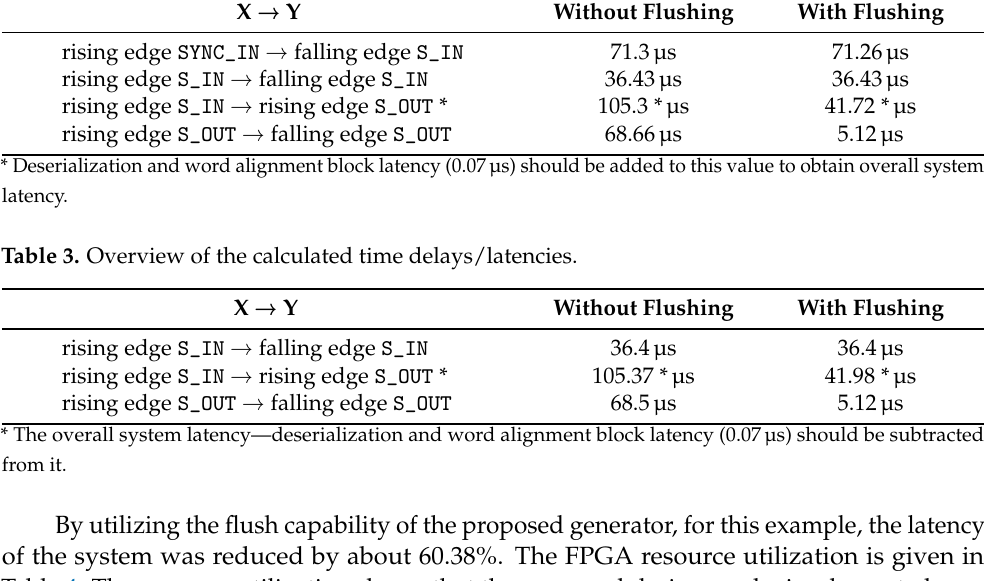
Table 2. Overview of the measured time delays/latencies. X → Y